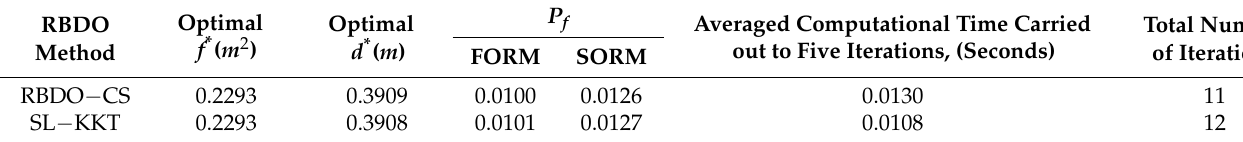
Table 3. Comparison between results from the RBDO − CS and SL − KKT approaches for the column design problem.